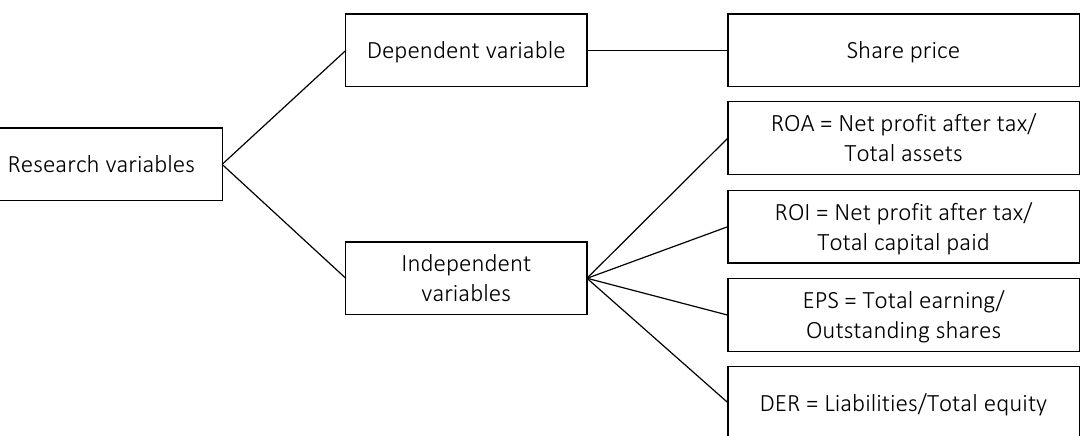
Figure 1. Explanation of dependent and independent